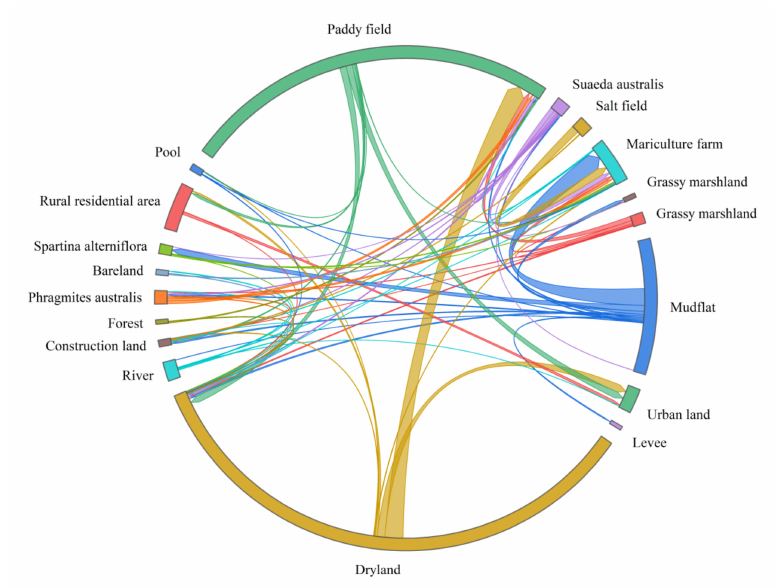
Figure 2. The area of the landscape transformation in the Jiangsu coastal area during the period 1980–2018.